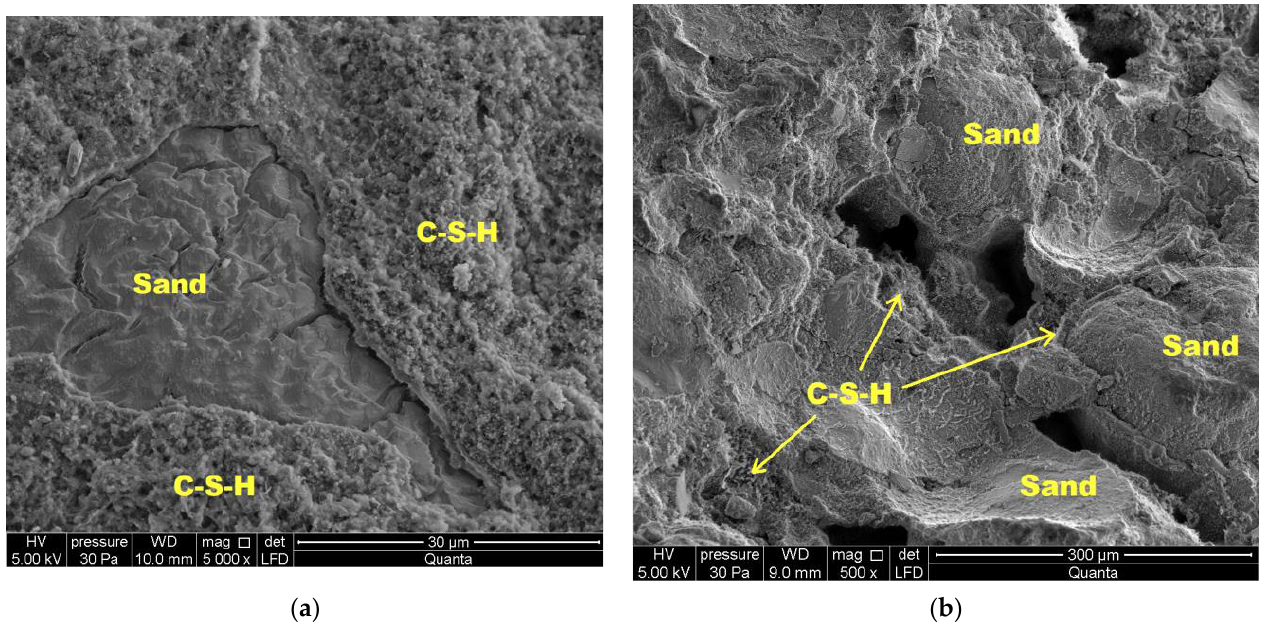
Figure 15. Microstructure of a BP30-W10 sample: ( a ) mag 5000 × ; ( b ) mag 500 ×